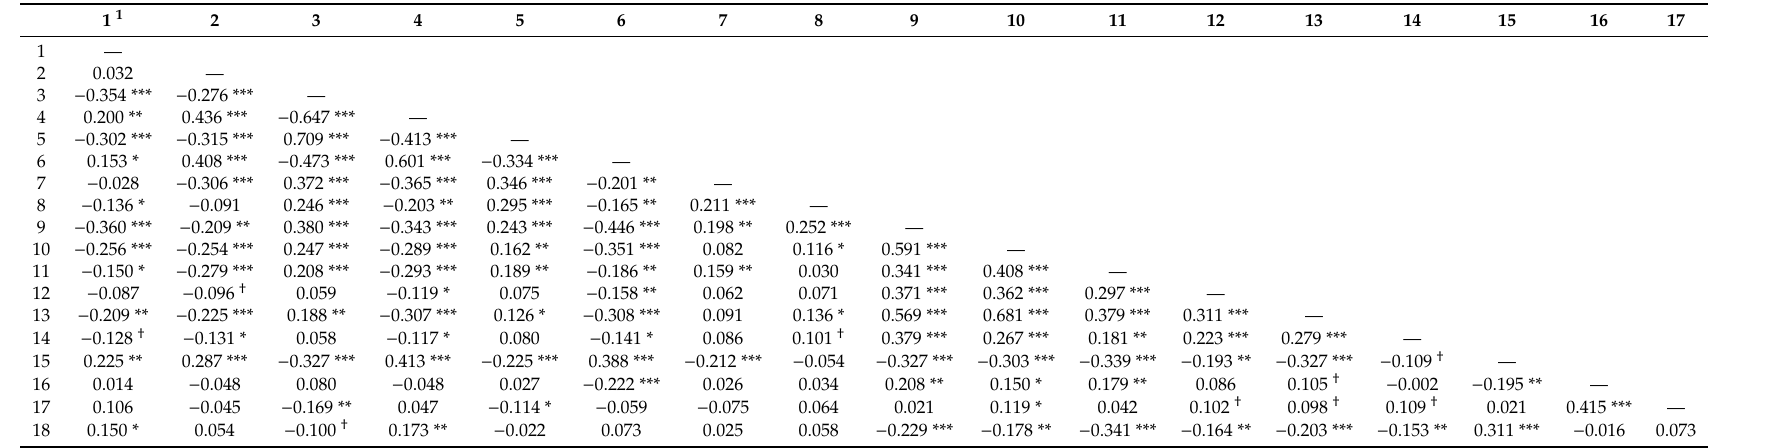
Table A2. The correlation among the study